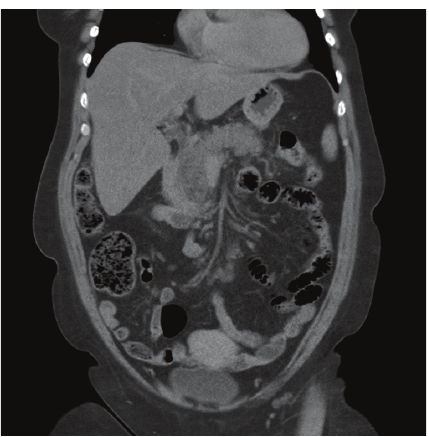
Figure 1: A computed tomography scan at the day of admission showing pancreatitis